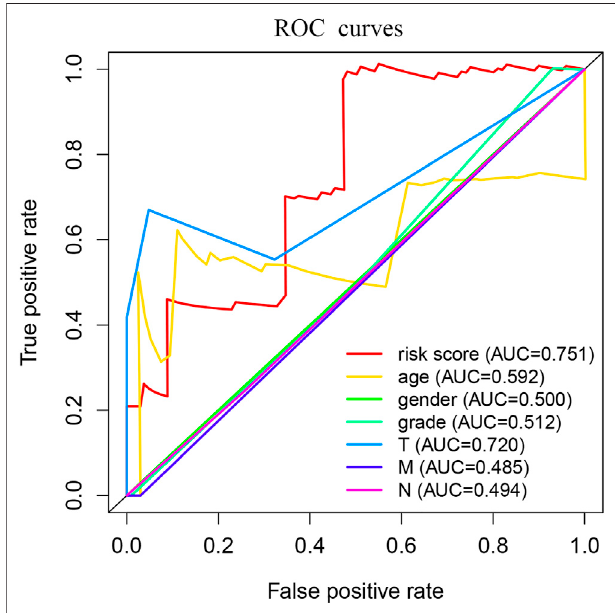
FIGURE 5 | ROC curve of MSMO1 expression related to each clinical pathological